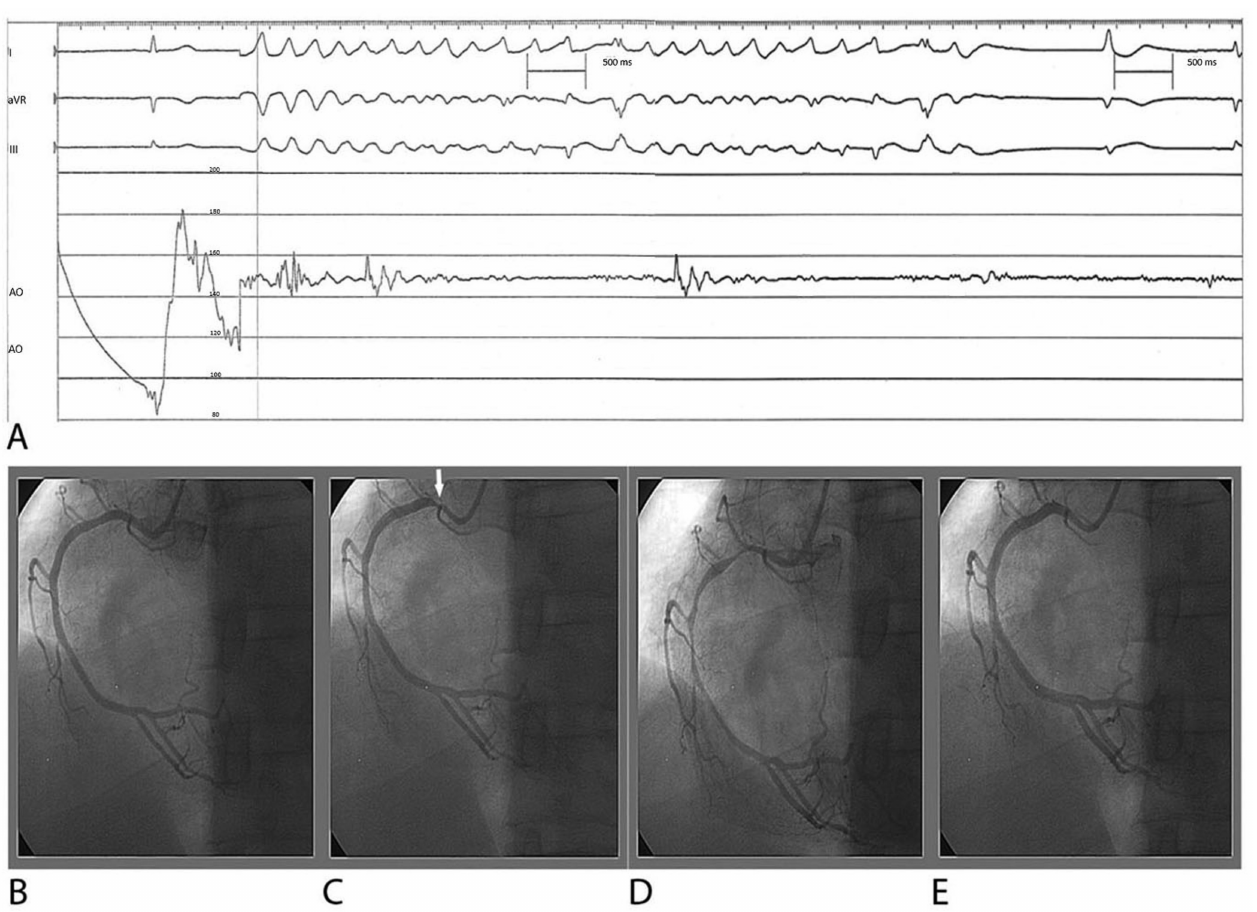
Figure 3. Epicardial CAS-induced VF: electrocardiograms, pressure tracing, and right coronary arteriogram in a 50-year-old male with unstable angina, presenting after wakening with rest angina at night. ( A ) Simultaneous lead I, II, aVR electrocardiogram, and systemic arterial pressure tracing during intracoronary ergonovine testing; ( B ) baseline angiographically normal right coronary artery with minimal plaquing; ( C ) ostial spasm (arrow) immediately after intracoronary administration of 15 µ g ergonovine; ( D ) in 10 s, the ostial spasm recovered spontaneously, multi-focal spasms appeared in the proximal and middle portion, and ventricular fibrillation occurred at the same time for 10 s and recovered spontaneously without intervention; ( E ) multi-focal spasms were relieved after intracoronary administration of 100 µ g nitroglycerin. The patient’s consciousness remained clear throughout the examination. (Reproduced from [63], with permission of the